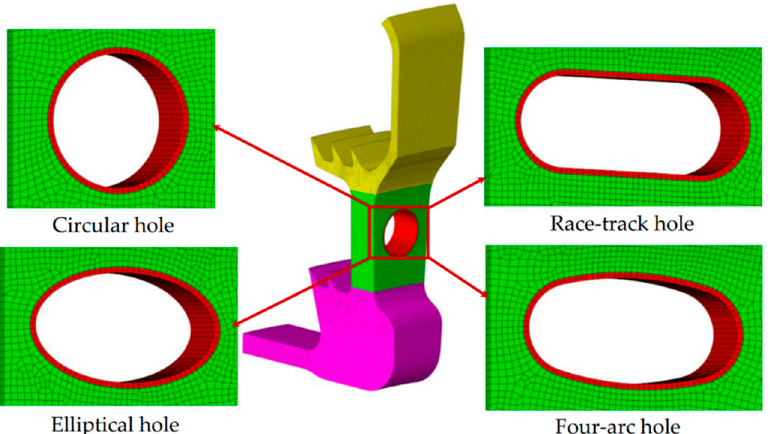
Figure 5. High-quality hexahedral mesh models for the single-hole sector sub-model with different shapes of vent